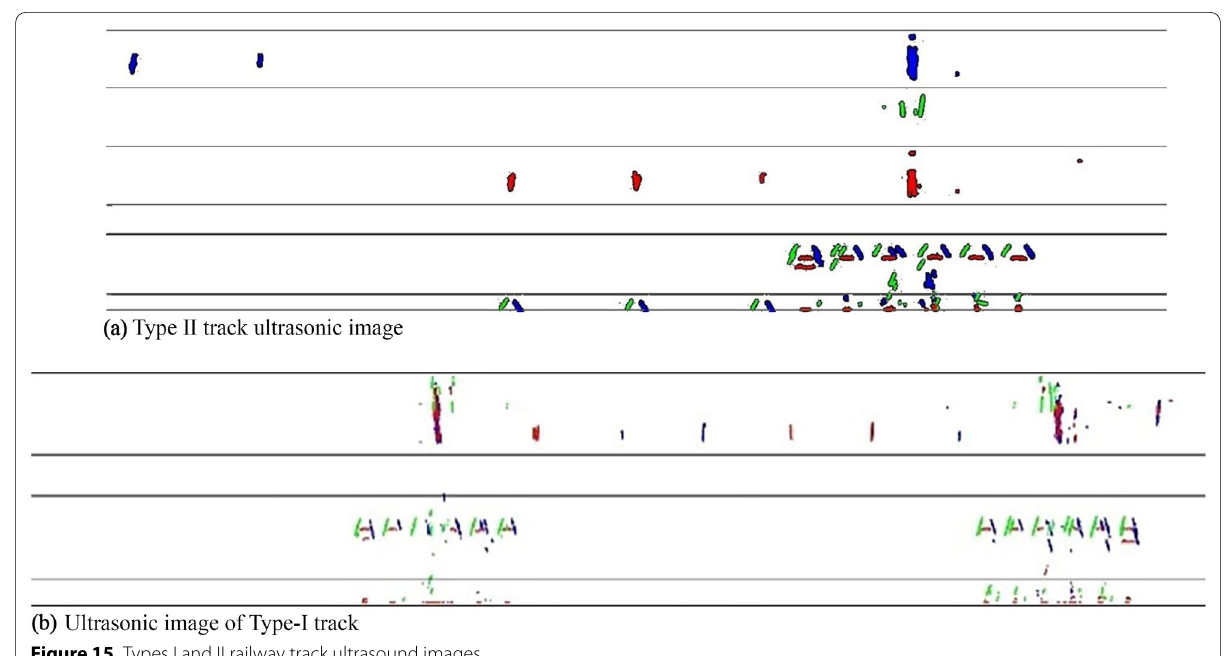
Figure 15 Types I and II railway track ultrasound